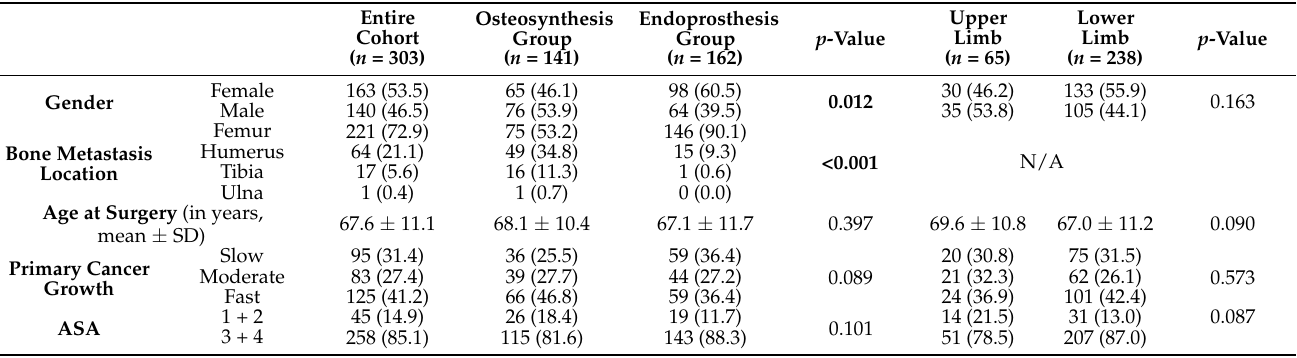
Table 2. Patient demographics, split by type of surgery (endoprosthesis vs. osteosynthesis) and metastasis location (upper vs. lower